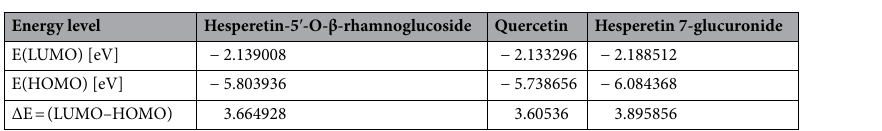
Table 2. The energy of HOMO, LUMO and ΔE = (LUMO–HOMO) of the four flavonoid compounds(eV).